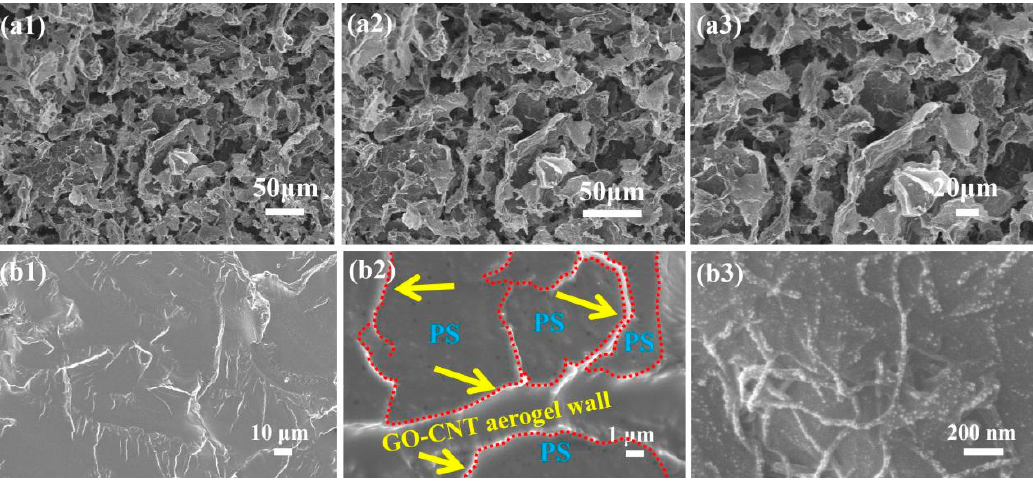
Figure 7. SEM images of ( a1 – a3 ) CNT-GO aerogels ( b1 – b3 ) the fractured surfaces of the CNT-GOA/PS.